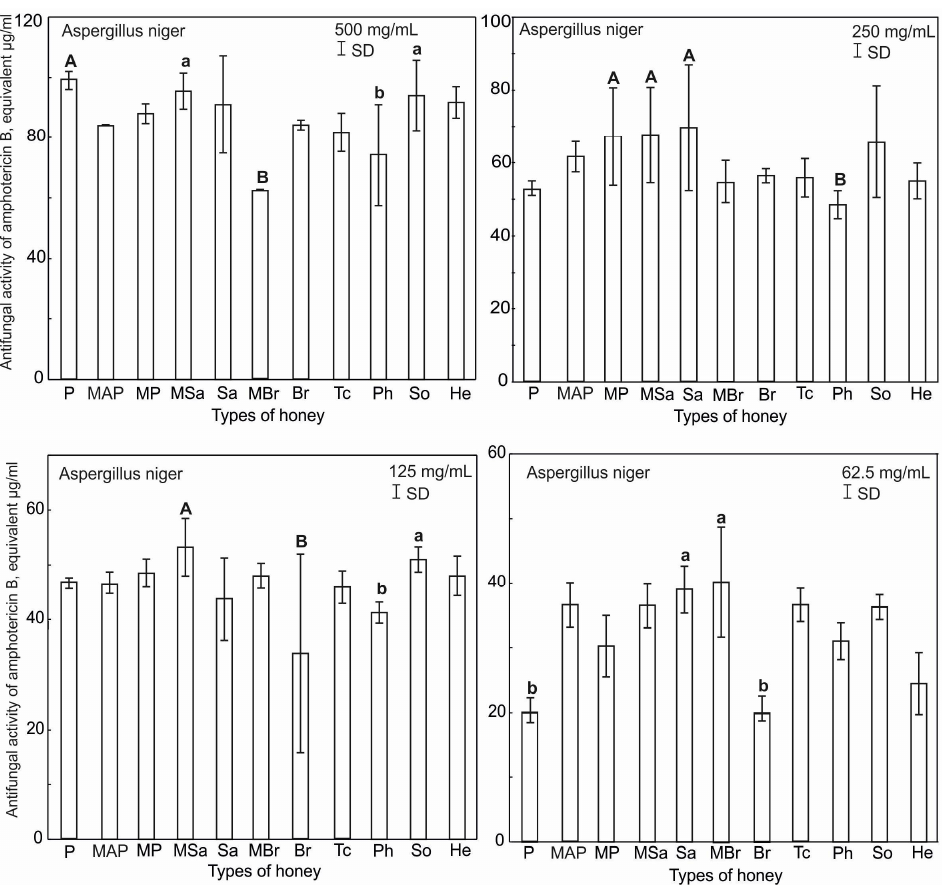
Figure 7. Results of ANOVA Kruskal–Wallis H test for the mean inhibitory activity of all the tested honey types and their concentrations against A. niger . Statistical differences are indicated by different letters and their significance at p ≤ 0.001 with capital letters (A), p ≤ 0.05 with lowercase letters (a). Upper and lower case letters above the bars indicate different levels of statistical significance.